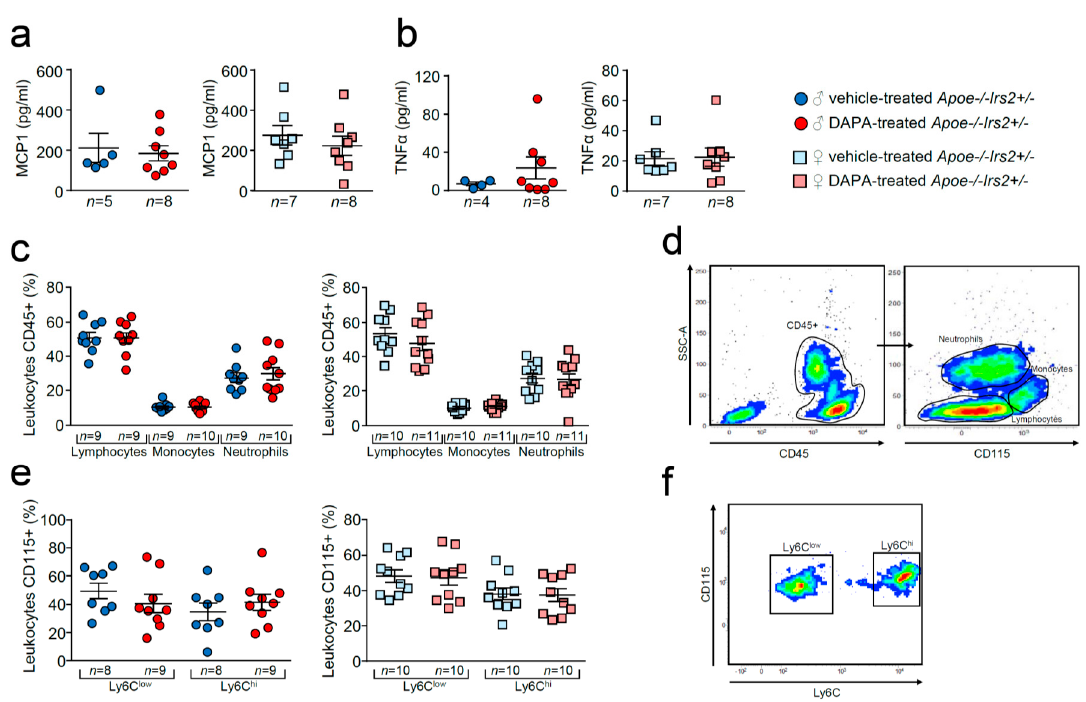
Figure 7. Effect of dapagliflozin in inflammatory mediators and cells in Apoe − / − Irs2+/ − mice. Circulating plasma levels of ( a ) MCP1 and ( b ) TNF α proinflammatory cytokines. ( c ) Circulating levels (in percentage) of lymphocytes, monocytes and neutrophils in the CD45+ population, identified by morphology and CD115 monocyte marker. ( d ) Representative cytometry plots of the gating strategy used for the flow cytometry analysis in the different leukocyte populations. ( e ) Circulating levels of monocyte subpopulations (in percentage) identified as CD45+CD115+Ly6C low pro-resolving and as CD45+CD115+Ly6C hi invasive monocyte subsets in male and female mouse blood. ( f ) Representative cytometry plots of the gating strategy used for monocyte subsets in blood samples. The statistical analyses for normal distribution were Kolmogorov–Smirnov test ( a , b ) and D’Agostino–Pearson test ( c , e ) and for differences were Mann–Whitney U test ( a , b ) and Student’s t -test ( c , e ).